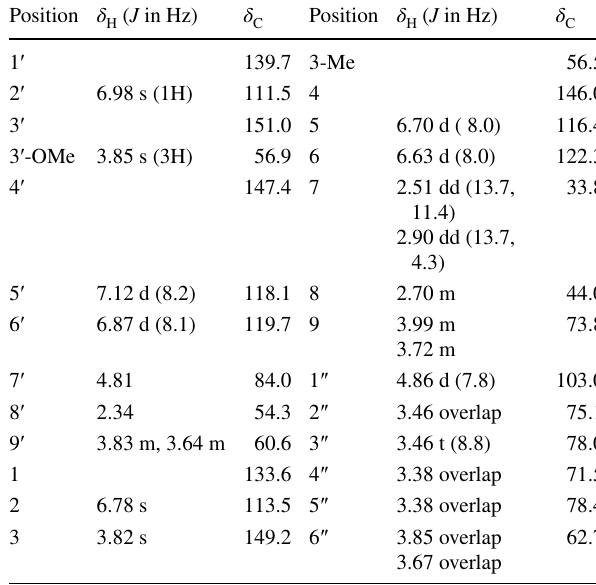
Table 3 NMR (400 MHz) spectroscopic data for Compound 7 in methanol- d